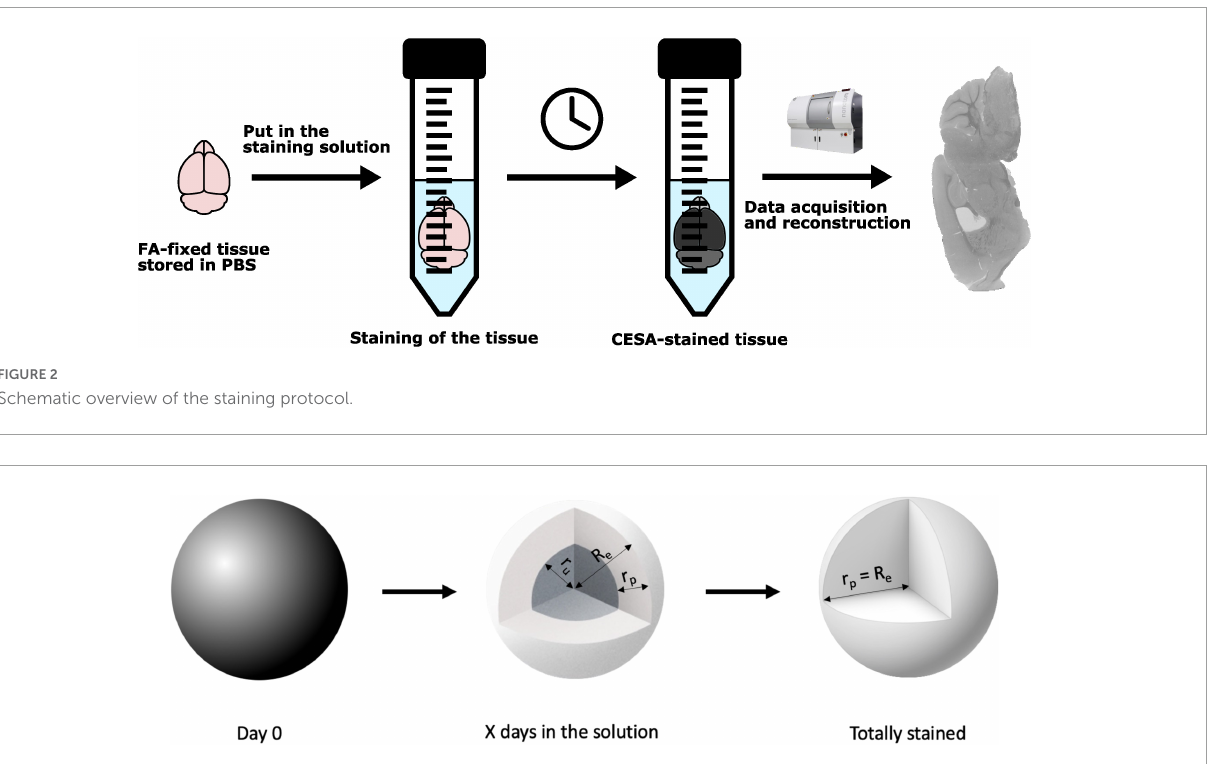
FIGURE3 Visual representation of spherical approximation of the penetration depth. The spheres represent the staining process (Dark gray = unstained, white = stained) and graphically show the meaning of the